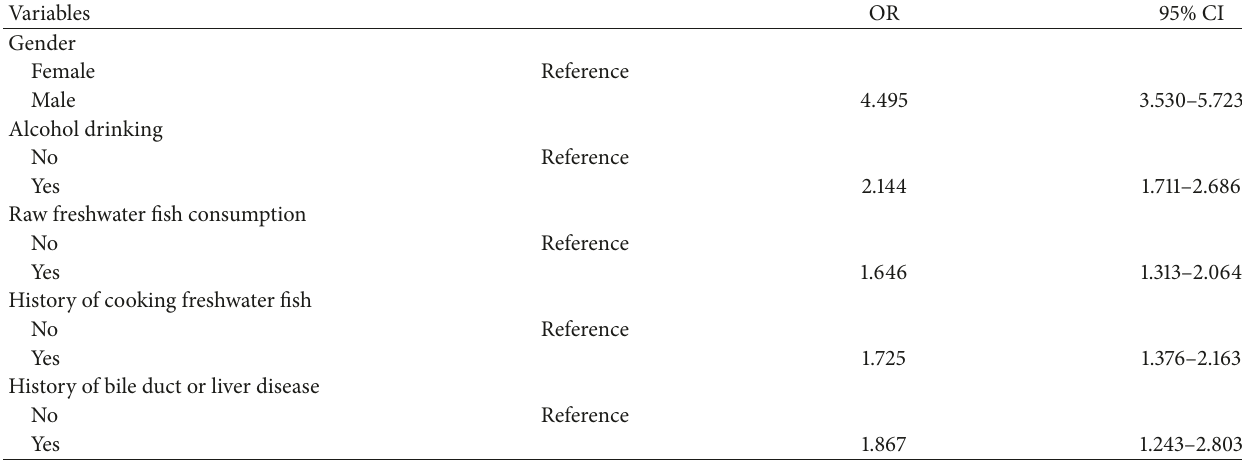
Table 4: Odds ratios (OR) and the 95% confidence intervals (CIs) for C. sinensis infection for patients with different characteristics.